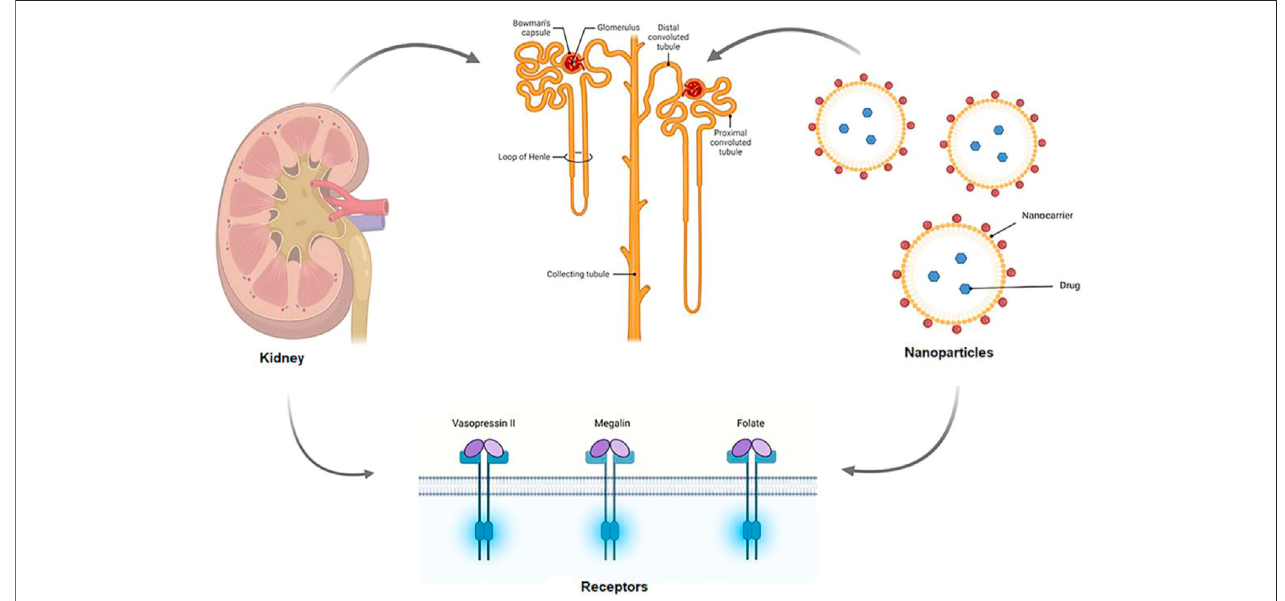
FIGURE 3 | Schematic mechanism of kidney targeted drug delivery. The renal artery transports drug-carrying nanoparticles to the afferent arteriole, where they remain in the bloodstream or are fi ltered out of the blood by the kidneys in the glomerular capillaries for further processing. Renal components such as the endothelial cells, GBM, and glycocalyx can all be modi fi ed to assist in the selection of NPs for fi ltration. Following fi ltering, NPs can interact with podocytes in the Bowman ’ s lumen. The NPs are transported to the proximal tubule, where they interact with proximal epithelial cells and may be reabsorbed (Merlin and Li,